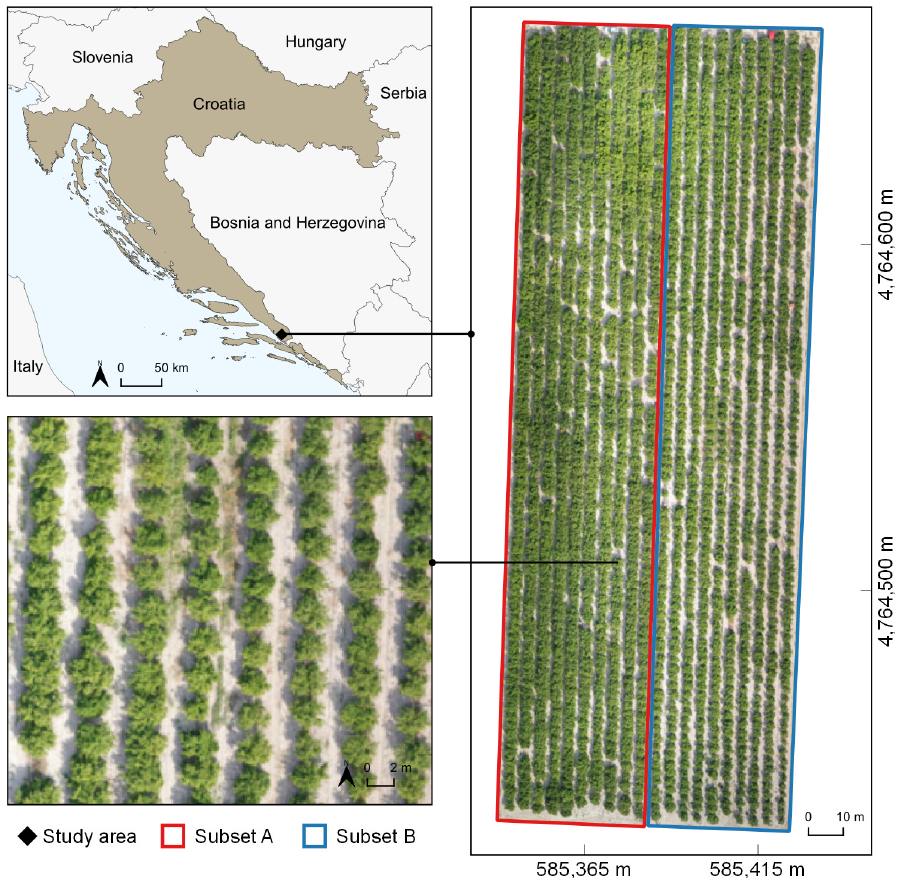
Figure 1. Tangerine plantation subsets in the Neretva river valley representing a study area.